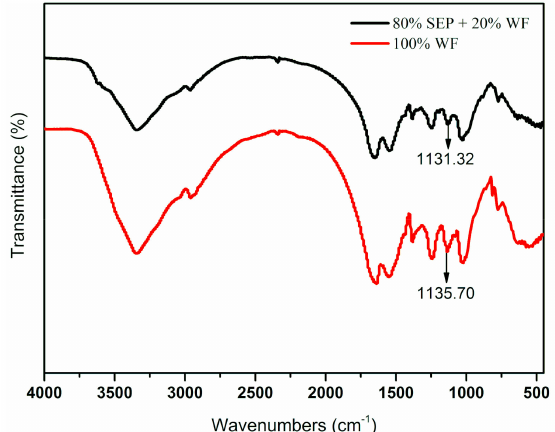
Figure 4. FTIR spectra of UF resin with di ff erent fillers: Resin A1—100% WF + 0% SEP; Resin A5—80% SEP + 20% WF.